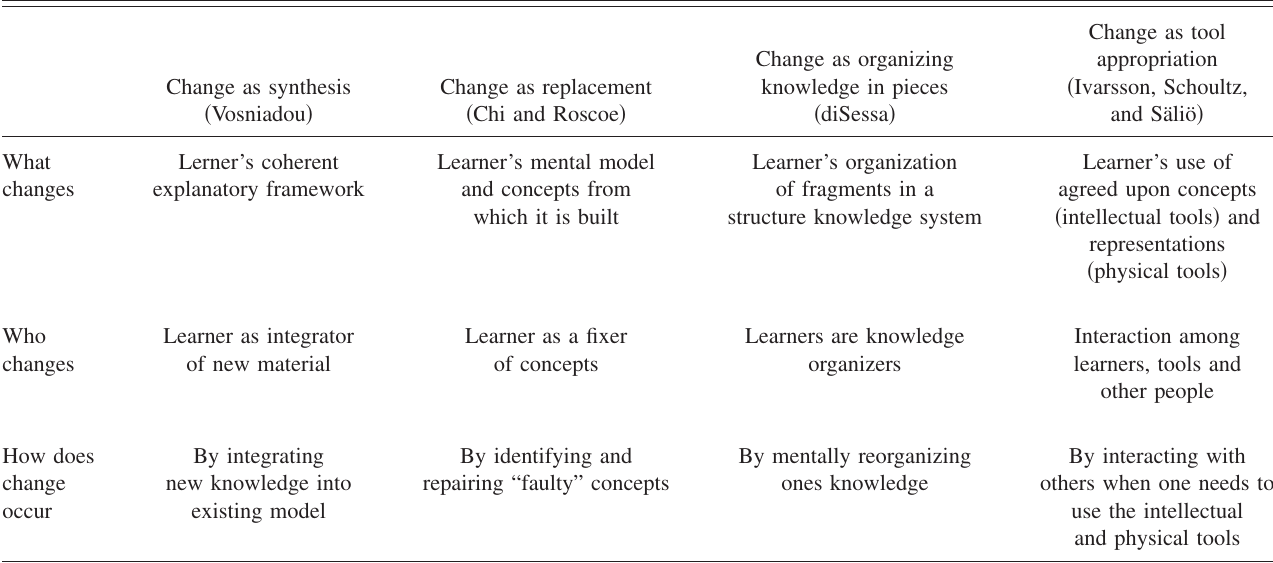
TABLE I. Four views of conceptual change based on Mayer.